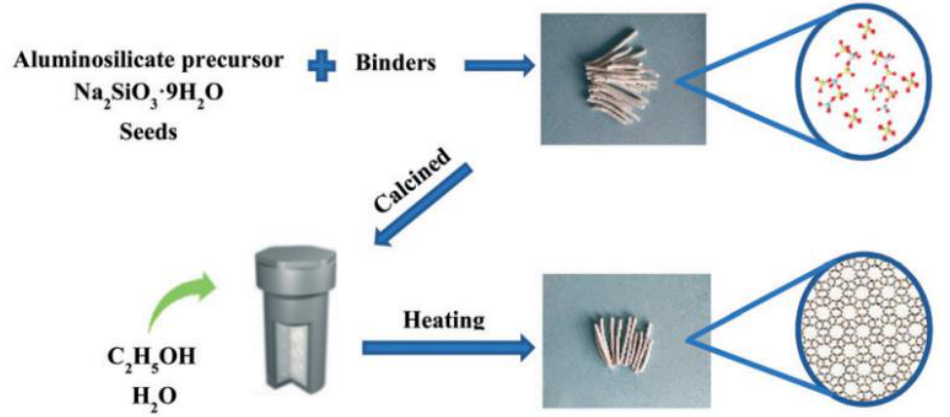
Figure 6. Schematic representation of the one-pot preparation of the fully crystalline-shaped zeolites catalysts. Reprinted with permission from ref. [124]. Copyright 2021, The Royal Society of Chemistry.